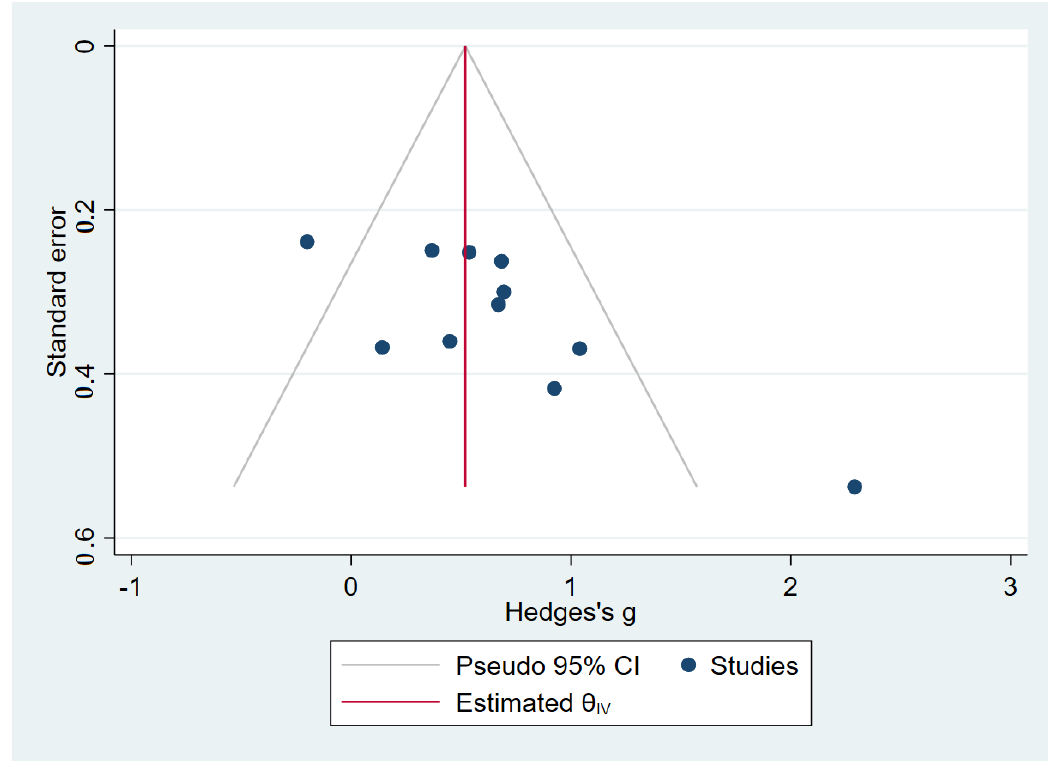
Figure 3. Publication bias funnel chart of the effect of resistance training on grip strength.